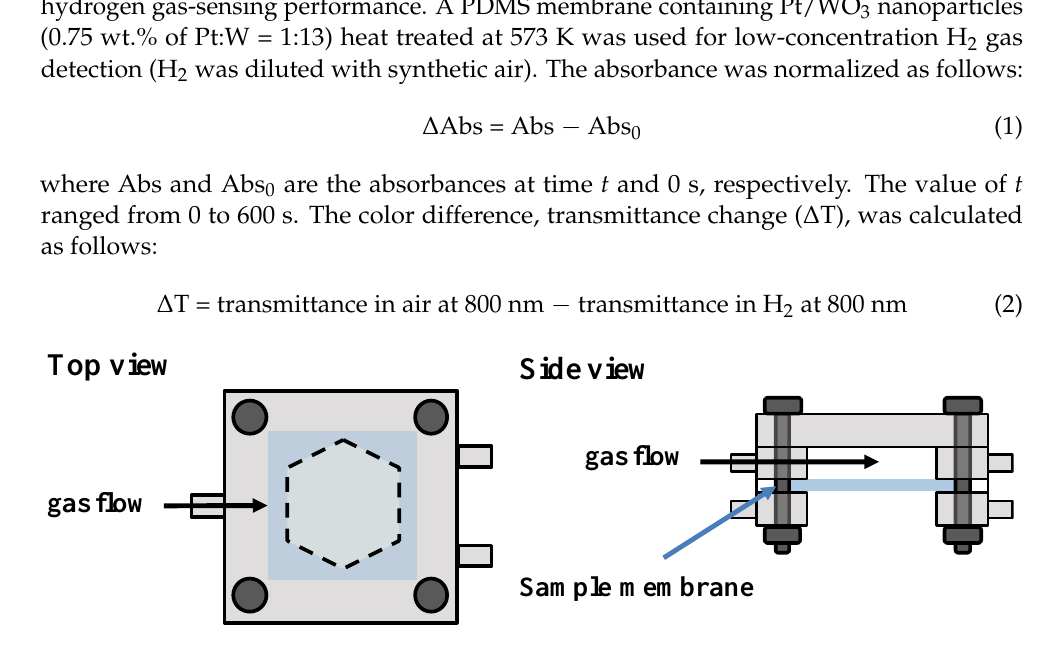
Figure 1. Experimental apparatus for evaluating H 2 gas response of membranes.